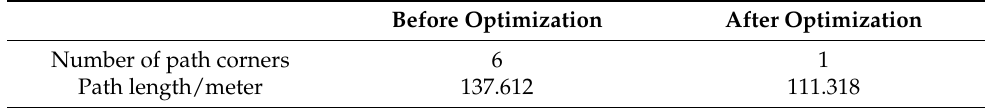
Table 2. The number of path corners and path length before and after optimization by DP. Before Optimization After Optimization Number of path corners